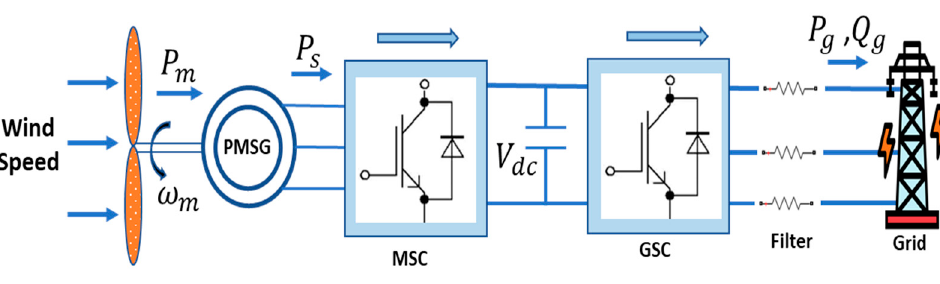
Figure 5. Schematic of a PMSG-WT.